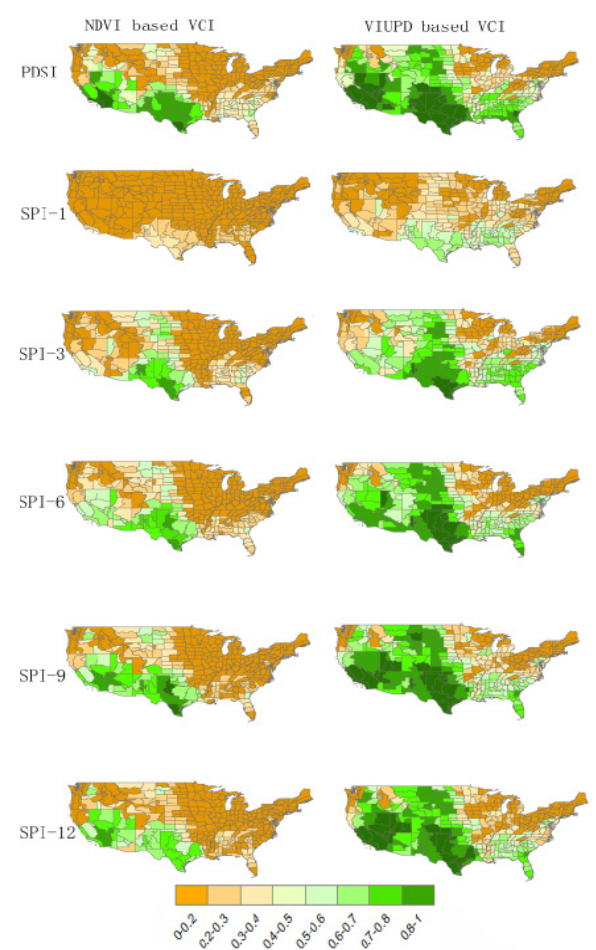
Figure 3. Spatial distribution of climate divisions with the correlations (r-value) between remote-sensing-based VCI and in situ drought indices for the entire growing season (April to October). Remote Sens. 2016 , 8 , 224 12 of 21